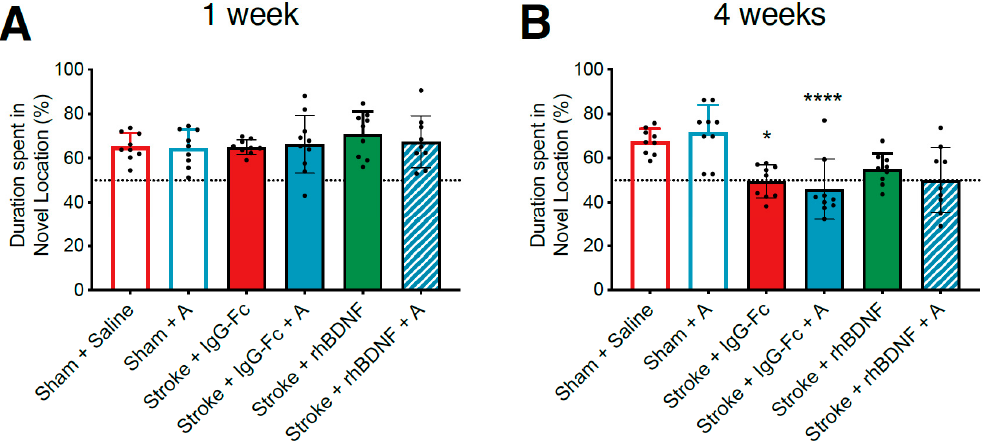
Figure 2. Effects of compound A treatment, with or without rhBDNF, on object location recognition task performance (OLRT) following PFC stroke. OLRT performance at one- ( A ) and four-weeks post-stroke ( B ) was compared between sham and stroke animals treated with vehicle (sham + saline, n = 9; stroke + IgG-Fc, n = 9), compound A (sham: n = 9; stroke: n = 10), rhBDNF (stroke only, n = 9) or compound A + rhBDNF treatment (stroke only, n = 9). At one-week post-stroke, all animals spent a similar percentage of the testing duration exploring the object in the novel location. In contrast, at four-weeks post-stroke, stroke animals treated with compound A or a vehicle solution spent significantly less time exploring the object in the novel location relative to their respective sham counterparts, indicating a delayed-onset impairment in spatial memory. However, one-way ANOVAs comparing the effect of co-administering rhBDNF with compound A failed to find any difference in the performance of all stroke animals at both timepoints. Two-way ANOVA: * p < 0.05, **** p < 0.0001, relative to saline-treated sham